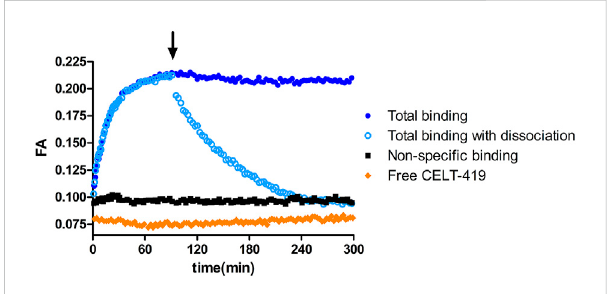
FIGURE 1 Time course of FA change caused by CELT-419 binding to D 3 receptor on the BBV particles. The reaction was initiated by the additionof1 μ LD 3 receptordisplayingBBVs(C D3R =0.7 nM)to 0.5 nM CELT-419 in the absence (blue circles) or presence (black squares) of 50 μ M Spiperone, or solution without BBVs (orange diamonds). After 90 min (indicated with an arrow), the measurement was paused, and dissociation was initiated by the addition of 333 μ M Spiperone (open light blue circles). An equivalent volume of assay buffer was added to association controls ( fi lled dark blue circles). A representative experiment of at least three independent experiments is shown.